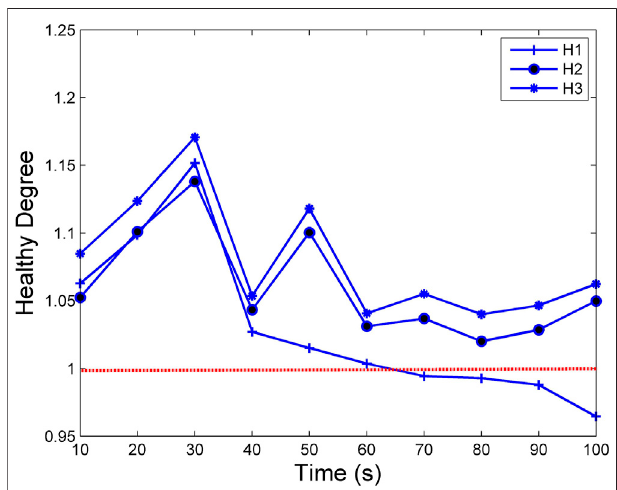
FIGURE 1 | Fault prediction curves of engine equipment from normal operation tofault 1. Itisobvious thatonly thehealthy degree offault prediction curveoffault1startstobelessthan1inthetimeperiod from60to70 s,andit decreases with time.